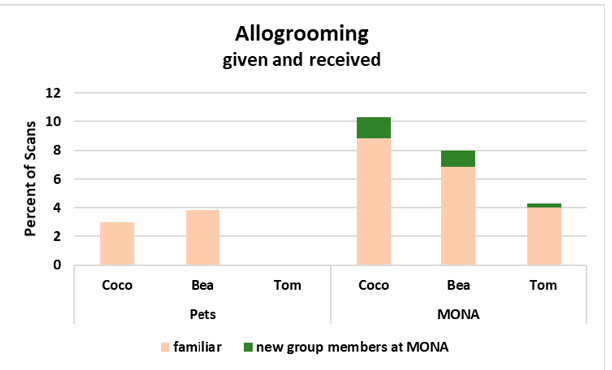
Figure 7. Percent of scans engaged in allogrooming when kept as pets and at MONA for Coco, Bea and Tom (shown as proportion of the total activity). Peach coloured = allogrooming exchanged with familiar conspecifics; green = allogrooming exchanged with new conspecifics at MONA. Comparing the close proximity networks showed that all three chimpanzees spent some time within an arm’s reach of their group members when kept as pets and at MONA